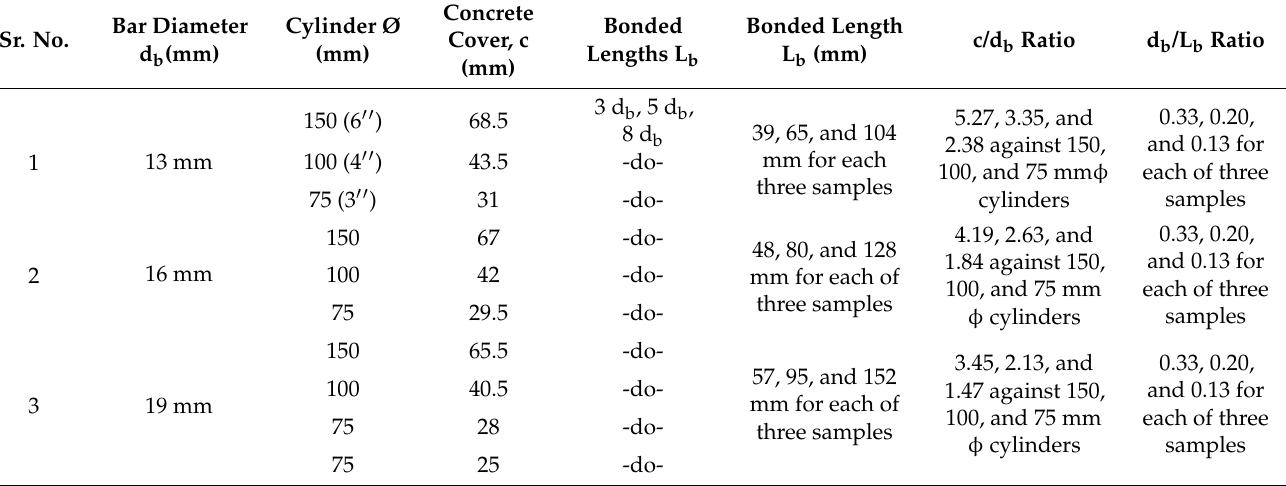
Table 3. Details of pullout test